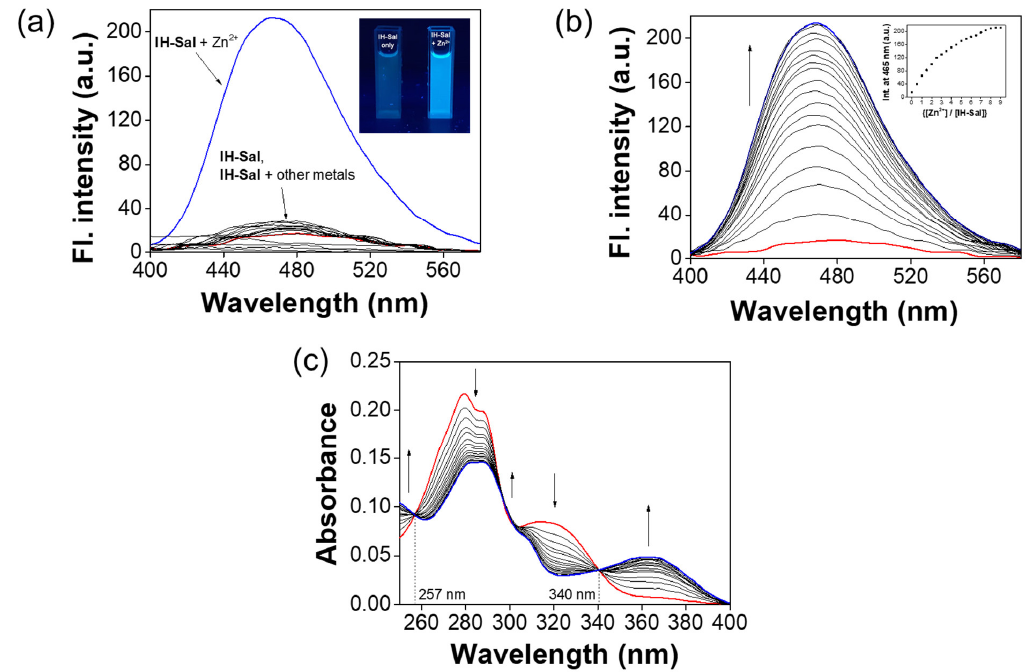
Figure 1. ( a ) Fluorescence changes in IH-Sal (1 × 10 −5 M) with varied cations (8.5 equiv). Photograph: the fluorescence images of IH-Sal and IH-Sal -Zn 2+ under UV light (λ ex : 369 nm); ( b ) fluorescence titration of IH-Sal (1 × 10 −5 M) with varied amounts of Zn 2+ (0–9 equiv); ( c ) UV–Visible variations in IH-Sal (1 × 10 −5 M) with varied amounts of Zn 2+ (0–8 equiv). To demonstrate the sensing characteristics of IH-Sal to Zn 2+ , a fluorescence titration of IH-Sal and Zn 2+ was conducted (Figure 1b). The fluorescence intensity of IH-Sal at 465 nm consistently increased up to 8.5 equivalent (equiv) of Zn 2+ . The photophysical charac- teristics of IH-Sal were also tested with UV–Vis spectrometry (Figure 1c). With the addi- tion of Zn 2+ to IH-Sal , the absorption of 250 and 360 nm consistently increased, and that of 290 and 320 nm decreased. There were clean isosbestic points at 257 and 340 nm, im- plying that one species was provided by the complexation of IH-Sal with Zn 2+ . On the other hand, the UV–Vis change in IH-Sal with various metal ions showed that IH-Sal was not selective to Zn 2+ (Figure S2). To confirm the stoichiometry of complexation, the Job plot experiment was carried out (Figure S3). The biggest intensity was shown at a mole fraction of 0.5, suggesting that IH-Sal and Zn 2+ formed a 1:1 binding compound. The 1:1 binding of IH-Sal -Zn 2+ was ver- ified by ESI-MS analysis (Figure S4). Positive ion mass displayed that the peak of 511.58 ( m/z ) was suggestive of [ IH-Sal (-H + ) + Zn 2+ + 2DMSO] + (calculated, 512.07). Based on the stoichiometry, the Benesi–Hildebrand equation [65,66] was used to calculate K (associa- tion constant) for IH-Sal -Zn 2+ (Figure S5). The K value was given to be 1.6 × 10 4 M −1 , which was within the scope of those (1 ~ 1.0 × 10 13 ) addressed for Zn 2+ sensors. The 1 H NMR titrations were executed to demonstrate the binding interaction of IH- Sal and Zn 2+ (Figure 2). With the addition of Zn 2+ to IH-Sal , the proton H 14′ disappeared and the proton H 9 was slightly moved to upfield. These results implied that the enol form of IH-Sal could interact with Zn 2+ using the oxygen of the deprotonated phenol and the nitrogen of the imine group (Scheme 2).